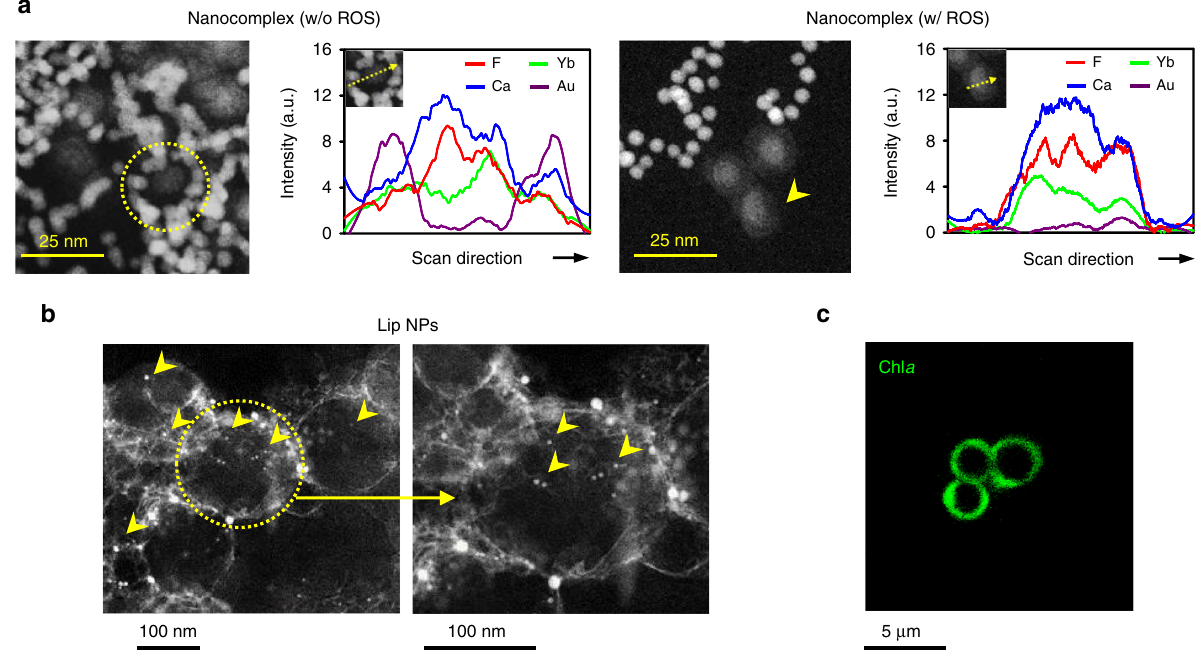
Fig. 4 ROS-sensitivity of nanocomplexes and structures of Lip NPs. a STEM images and elemental linescans of nanocomplexes in the absence/presence of ROS. b STEM images and c CLSM image of Lip NPs. Owing to the limited optical resolution in CLSM, Lip NPs that had undergone centrifugation and had diameters (2 – 3 μ m) were observed. Source data are provided as Source Data fi